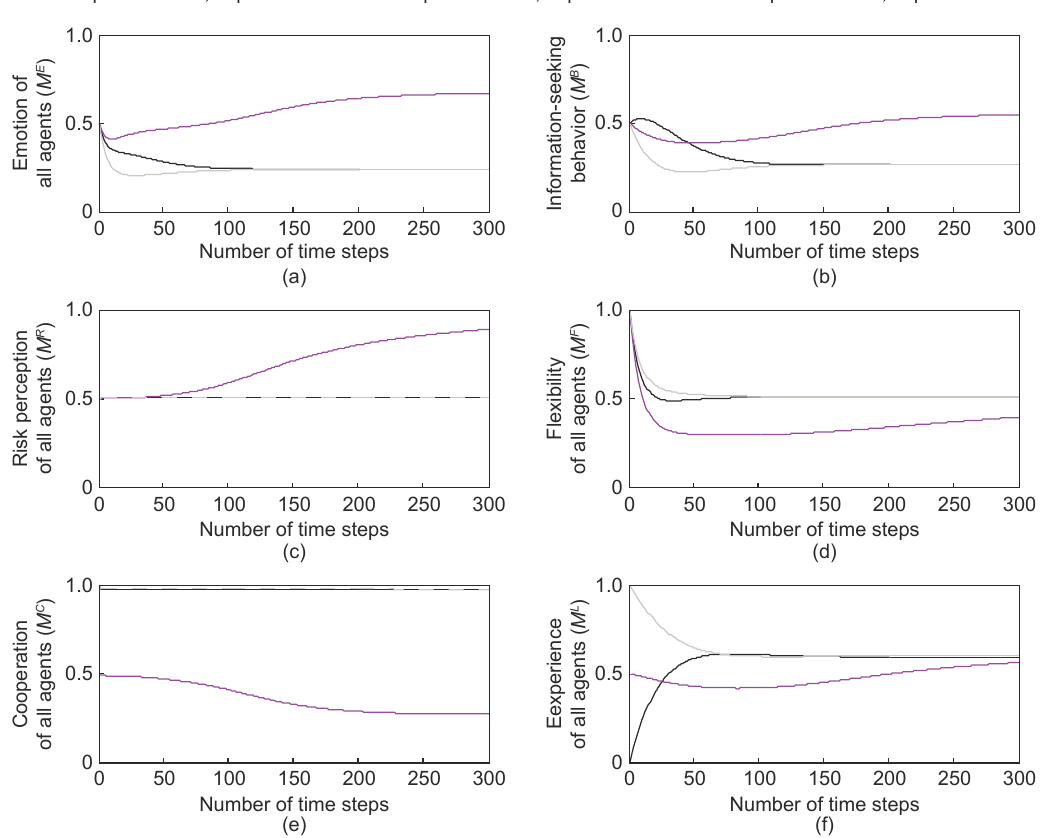
Fig. 4 Effects of different initial values of cooperation and experience on the dynamic change of the collective mental behavior in the homogeneous community. Black lines are related to individuals who are well-experienced and enthusiastic to cooperate. Grey lines are related to individuals who are not interested in cooperating at all. Purple lines are related to individuals who are only partially experienced with average or low levels of enthusiasm to